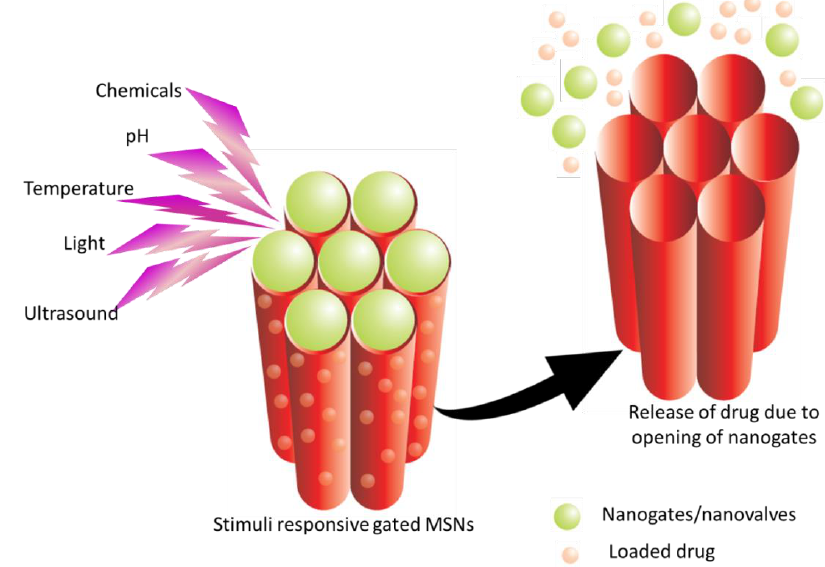
Figure 5. Schematic illustration of the release of drug from gated MSNs in response to stimuli.